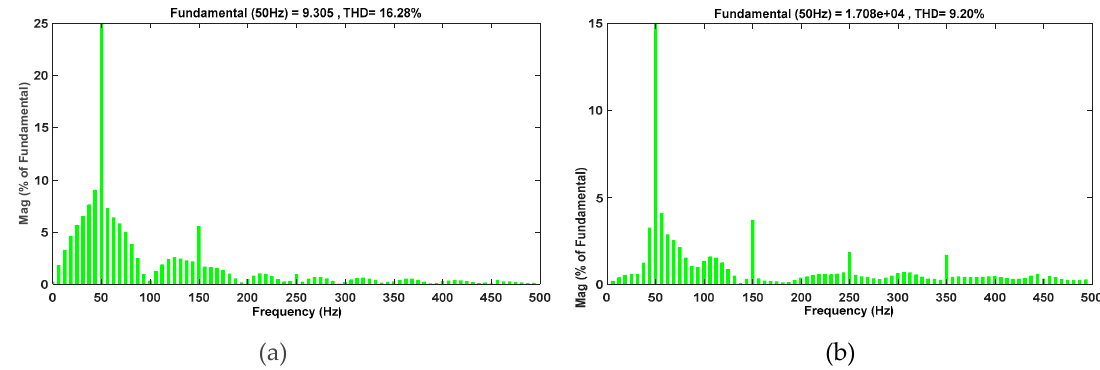
Figure 17. THD with LM + BFCL scheme for grid current ( a ) and voltage ( b ) during the P-G